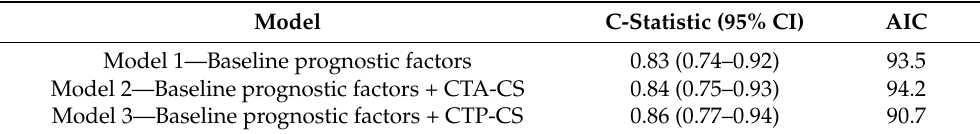
Table 4. Logistic regression models for favorable functional outcome with C-statistics and Akaike information